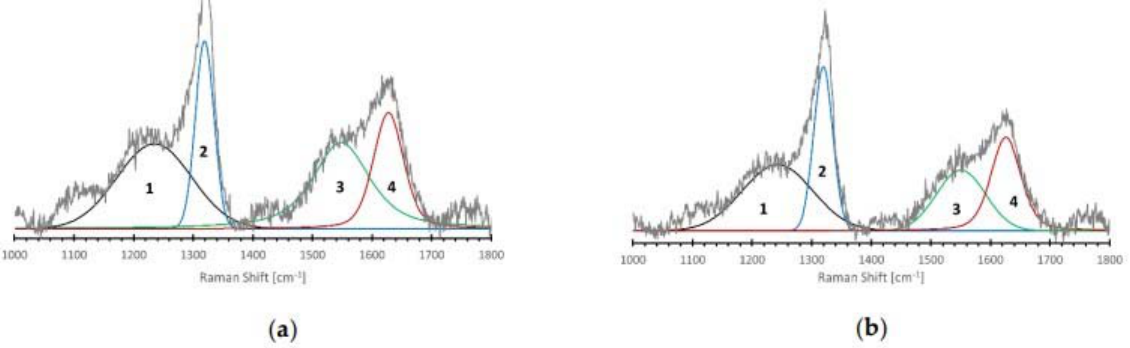
Figure 8. Raman spectroscopy images of diamond nanoparticles. ( a ) Raman spectrum of detonation nanodiamond parti ‐ cles manufactured by detonation method (DND)–ID/IG–0.93; and ( b ) Raman spectrum of detonation nanodiamond par ‐ ticles modified by the plasma ‐ chemical method (MDP1)–ID/IG–1.24. Table 3. Analysis of the Raman spectra.